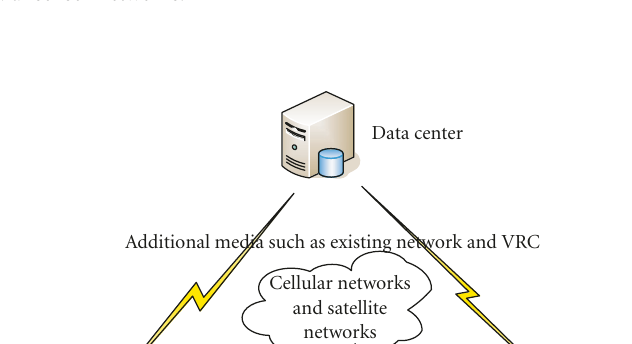
Figure 1: Vehicular sensor networks.